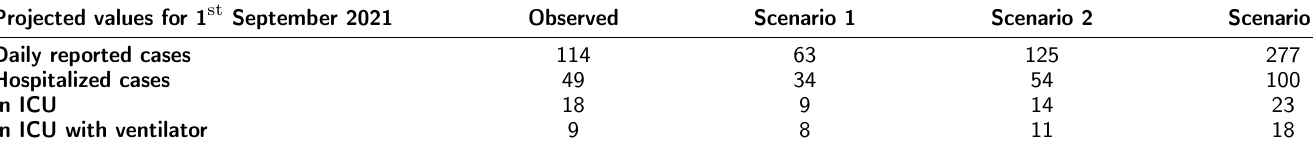
Table A3.3.2: Healthcare Usage projections for validation scenarios